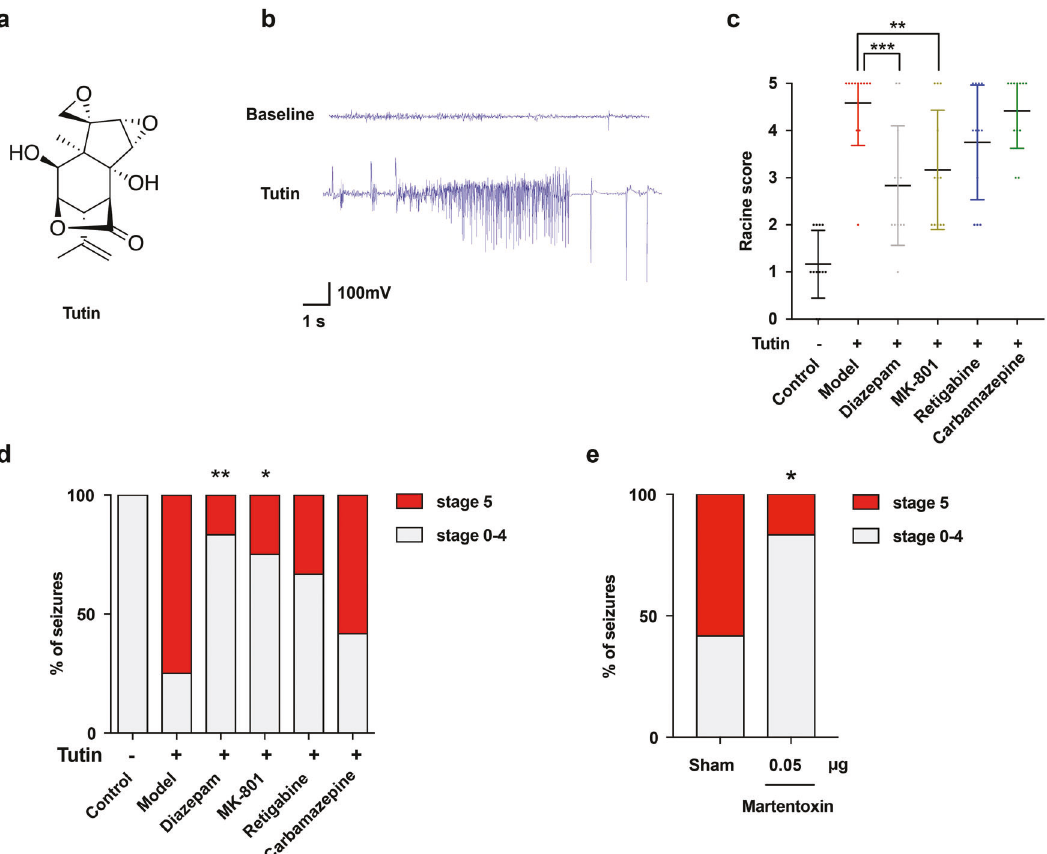
Fig. 1 Epilepsy caused by tutin is antagonized by diazepam and MK-801 in mice. a Chemical structure of tutin. b EEG (1-min) tracings during the pre-injection baseline and tutin injection. c Effects of antiepileptic drugs on maximum Racine score within 2 h after tutin injection. Results were represented as mean ± SD with n = 12, ** P < 0.01, *** P < 0.001 vs. model group. d Effects of antiepileptic drugs on the intensity of the seizure attack in mice ( n = 12). * P < 0.05, ** P < 0.01 vs. model group. e Effect of martentoxin on the intensity of the seizure attack in mice (* P < 0.05 vs. sham group, n =